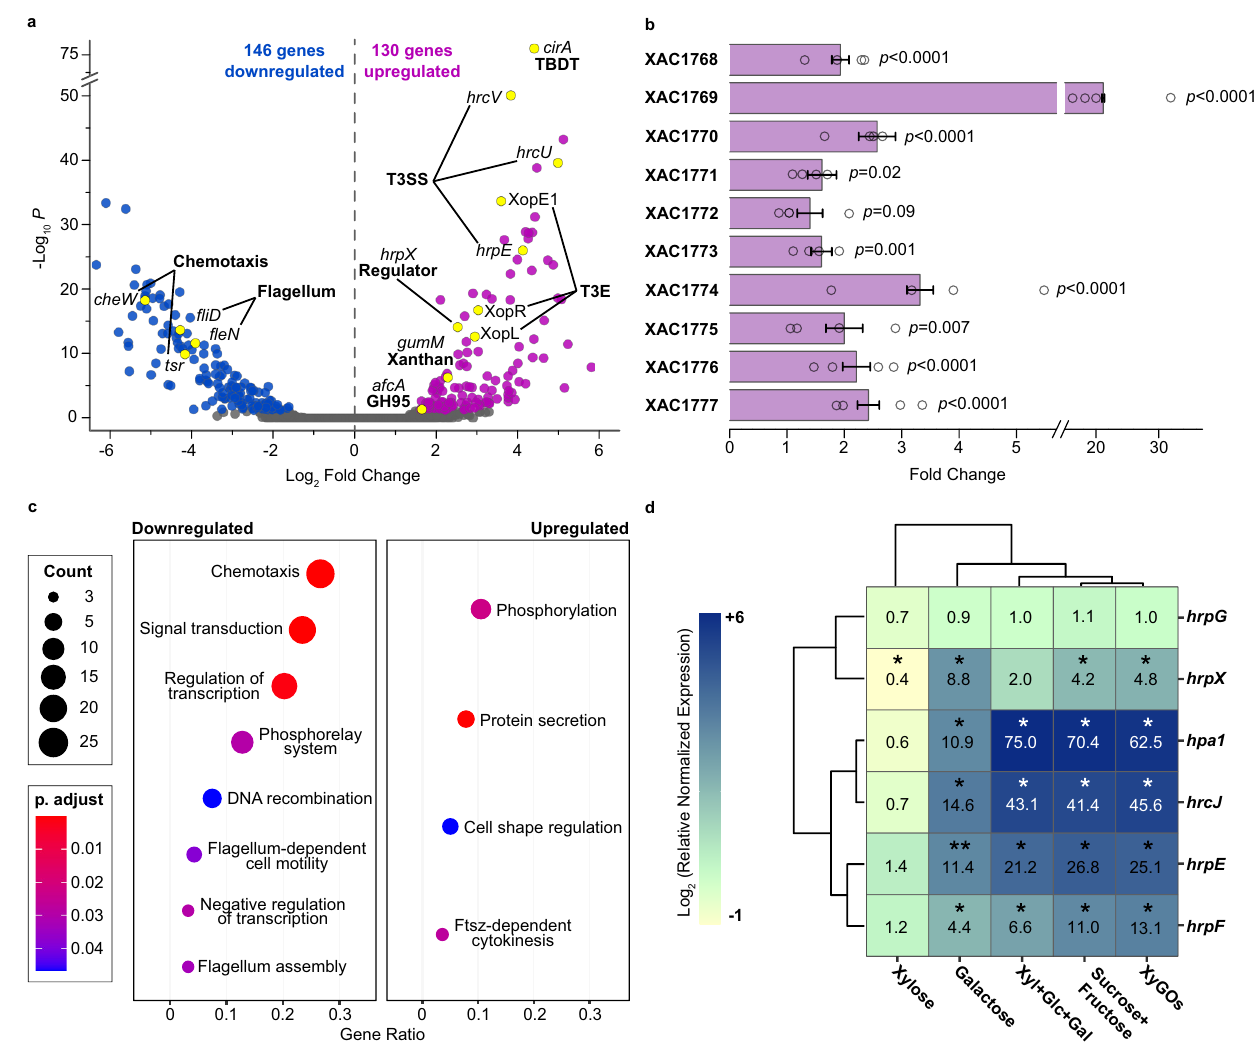
Fig. 5 Transcriptional responses to XyGOs in X. citri . a Volcano plot of RNA-seq data highlighting differentially expressed genes (DEGs; blue circles = downregulated and purple circles = upregulated). In yellow are DEGs acting on processes important for virulence or XyG utilization. Genes were considered differentially expressed according to Wald test implemented in DESeq2. p -values were adjusted for multiple tests using the Benjamini- Hochberg (BH) method implemented in DESeq2. Thresholds: p -adjusted < 0.05 and | log 2 Fold Change| > 1. b Transcription levels of XyGUL genes, downstream genes encoding xylose metabolism and MFS transporter in RNA-seq experiments. Data shown as mean ± SE from four biologically independent experiments ( n = 4) (open circles). Threshold: BH adjusted p- value < 0.05. c Gene ontology (GO) enrichment analysis of DEGs. Circles size and color represent the counts and BH adjusted p- values, respectively, according to the legend at the left. Gene ratio is the number of DEGs related to a GO term divided by the total number of annotated DEGs. Categories were considered enriched based on hypergeometric test, implemented in